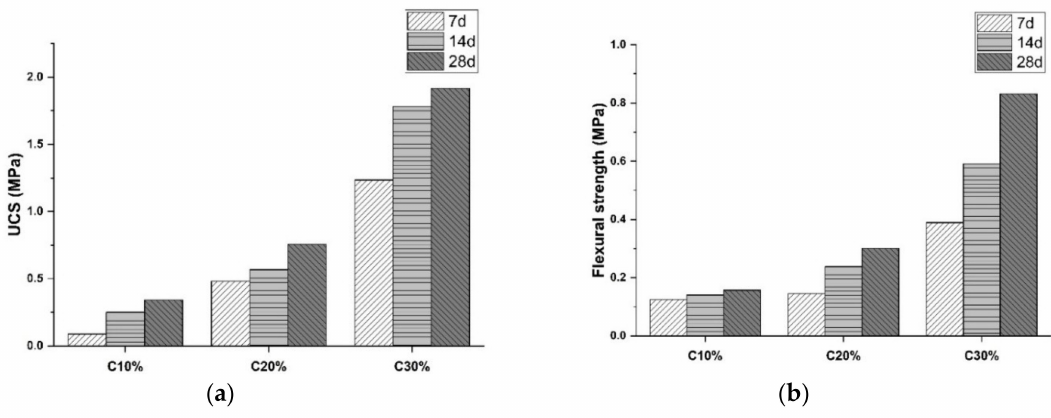
Figure 5. Mechanical results of control groups: ( a ) UCS test, ( b ) FS test (Note: C represents Portland cement).